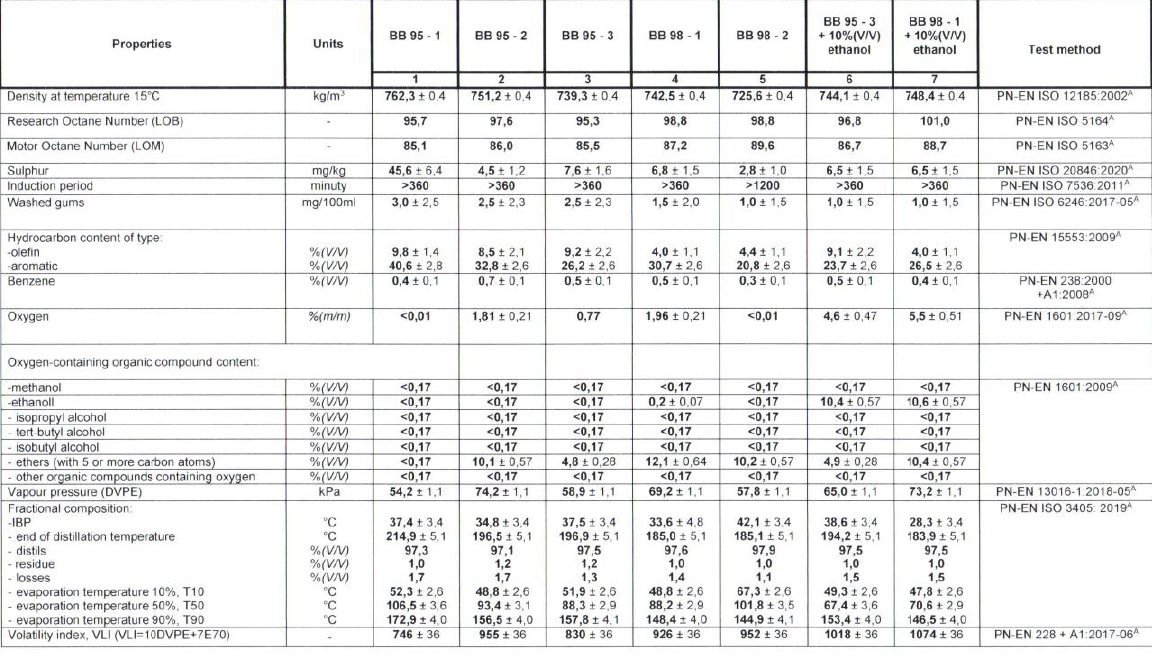
Table 2. Physicochemical properties of gasoline samples prepared for engine